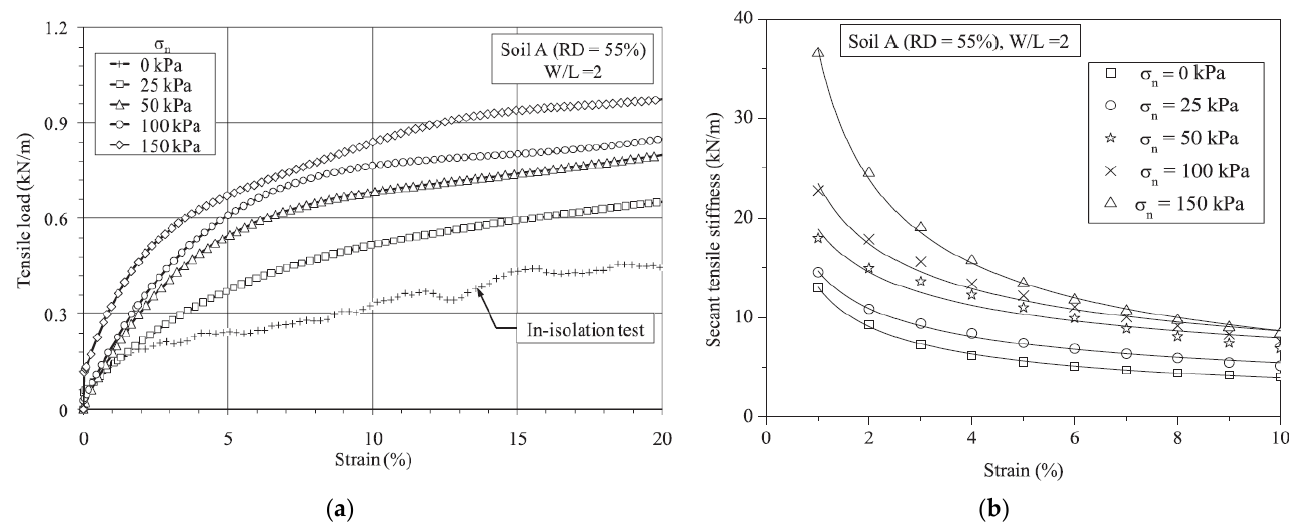
Figure 5. ( a ) Effect of normal stress on the: ( a ) tensile strength of geogrid ( b ) secant tensile stiffness of geogrid [85].